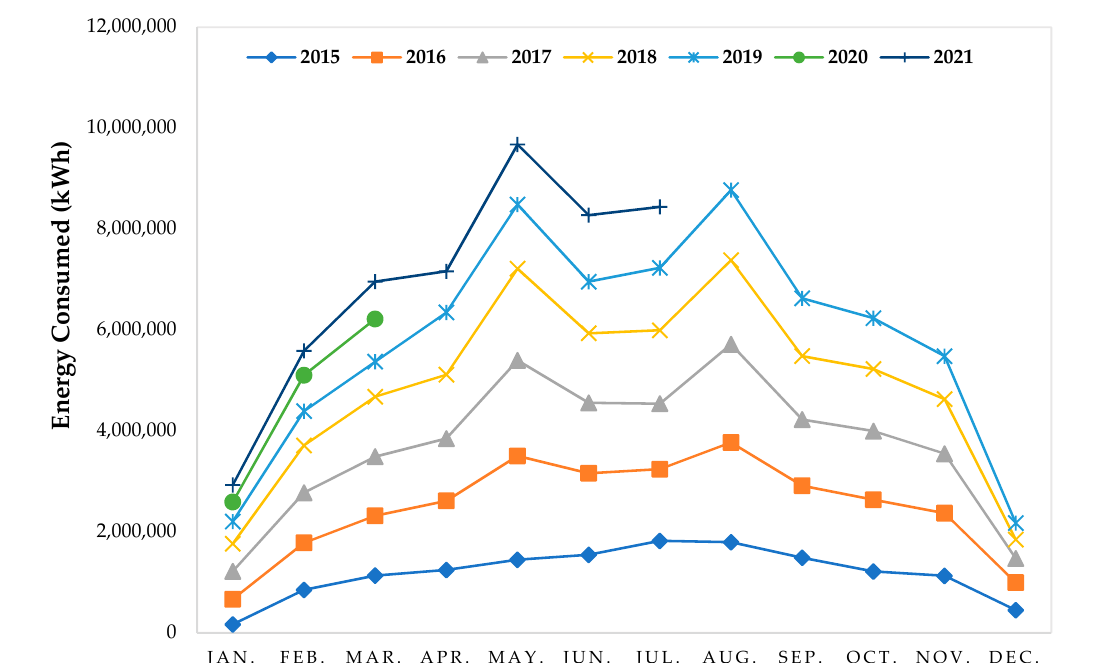
Figure 5. UJ-Res total monthly energy consumption (in kWh) from January 2015 to July 2021.